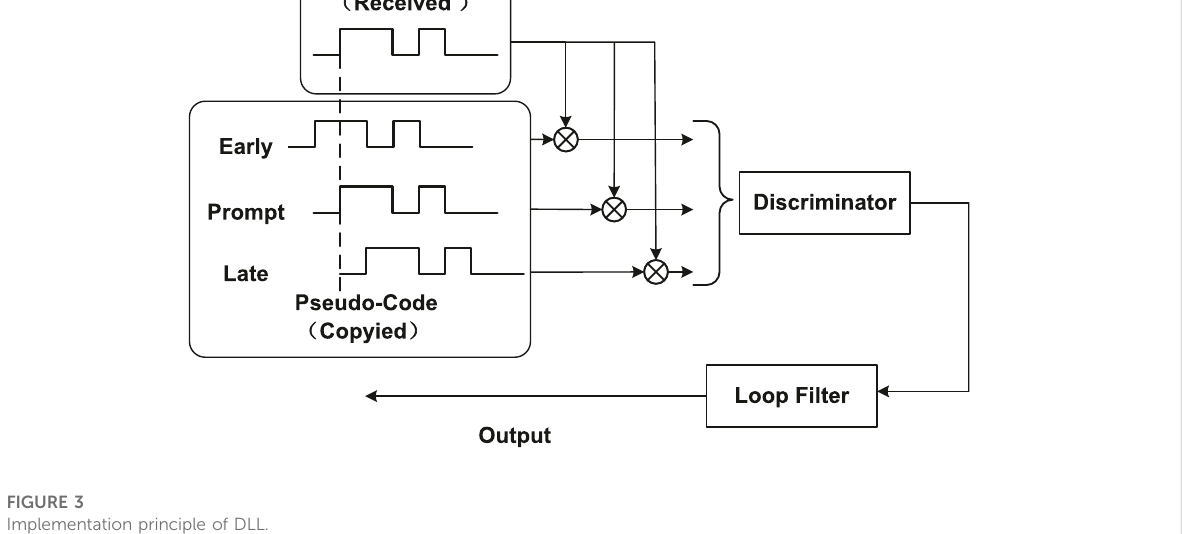
FIGURE 3 Implementation principle of